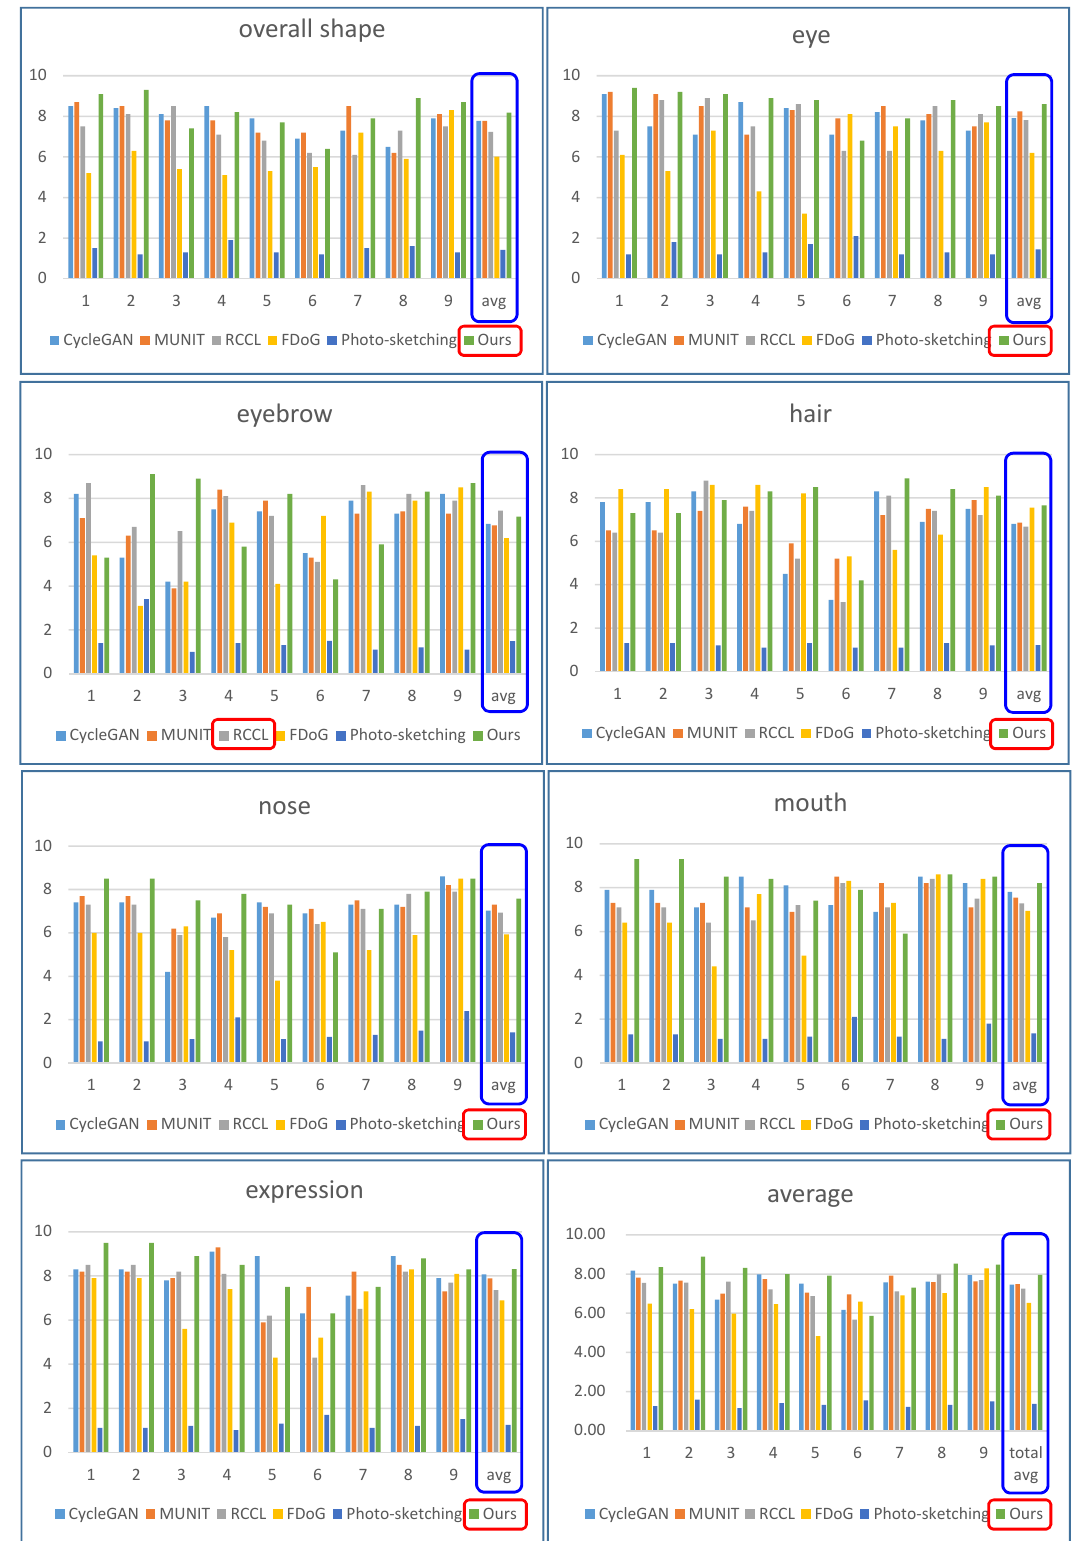
Figure 8. The analysis of the user study. The average scores are presented in the blue box, and the model with the best score is presented in the red box. The proposed model records the six best scores for the individual scores and the best score for the overall average